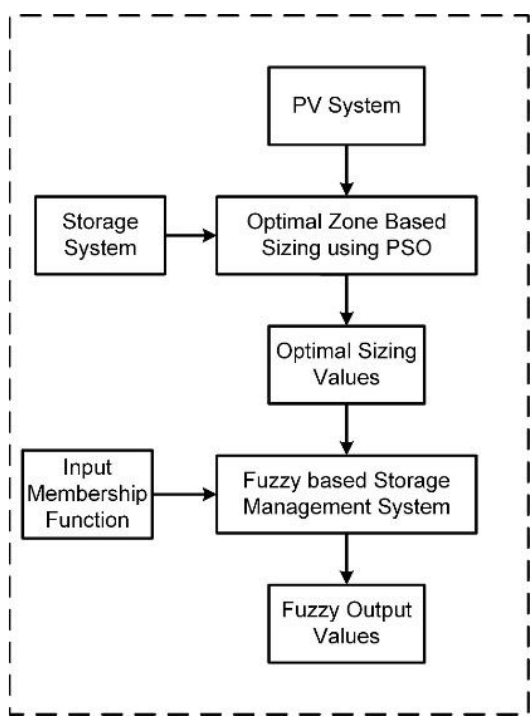
Figure 3. Block diagram of the proposed strategy.